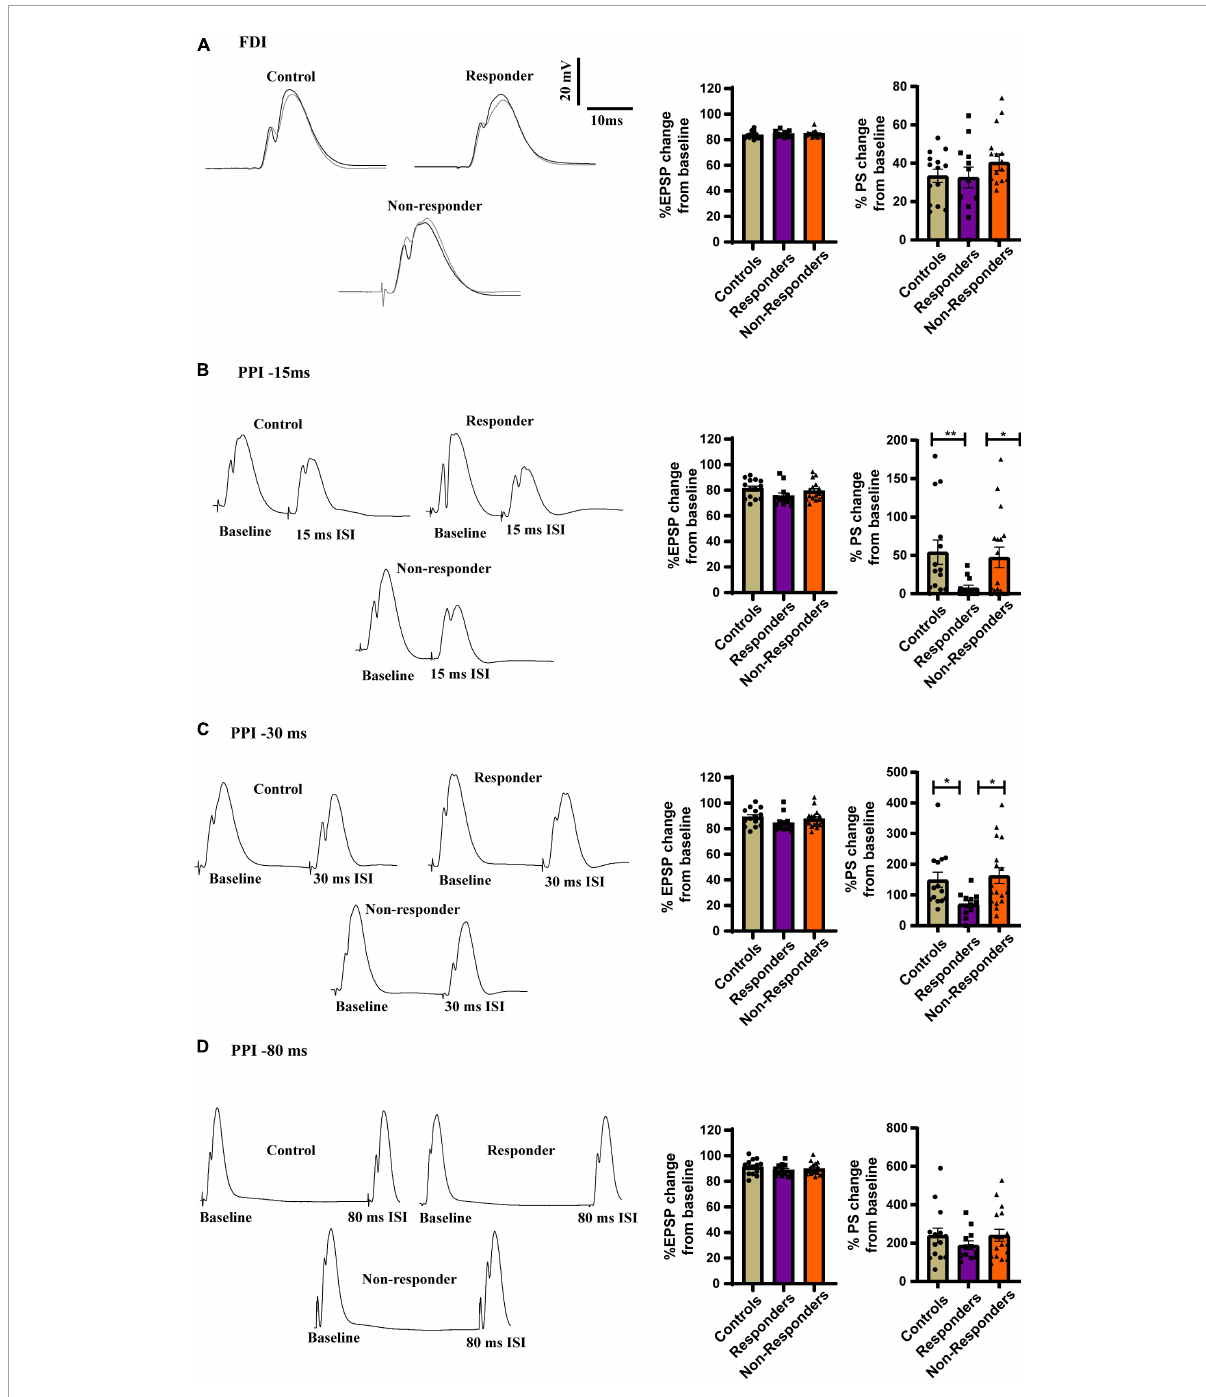
FIGURE8 Increased inhibition in PPI at inter-stimulus interval of 15ms and 30 ms in responders . ( A , left) Representative traces of FDI for controls , responders and non - responders showing feed-forward inhibition. (Right) Bar graphs of perecenatge change in EPSP slope [Kruskal–Wallis test (H(3) = 2.609, p = 0.2713)] and PS amplitude between the groups showed no change [Ordinary-one way-ANOVA (F ( 2 , 41 ) = 0.3740)]. ( B , left) Representative traces of PPI at 15ms ISI for controls , responders and non - responders showing feed-back inhibition. (Right) Bar graph representing perecenatge change in EPSP slope did not show change any difference [Kruskal–Wallis test (H(3) = 4.230, p = 0.1207)]. Decreased PS amplitude in the responders than controls and non - responders indicated incrased feed-back inhibition the DG of the responders [Kruskal–Wallis test (H(3) = 10.27, p = 0.0059); Dunn’s post-hoc comparison p ** < 0.01. p * < 0.05]. ( C , left) Representative traces of PPI at 30 ms ISI for controls , responders and non - responders . Majority of control and non - responders showed fasciliation at 30 ms ISI while responders showed feed-back inhibition. (Right) Bar graph representing perecenatge change in EPSP slope did not show any difference